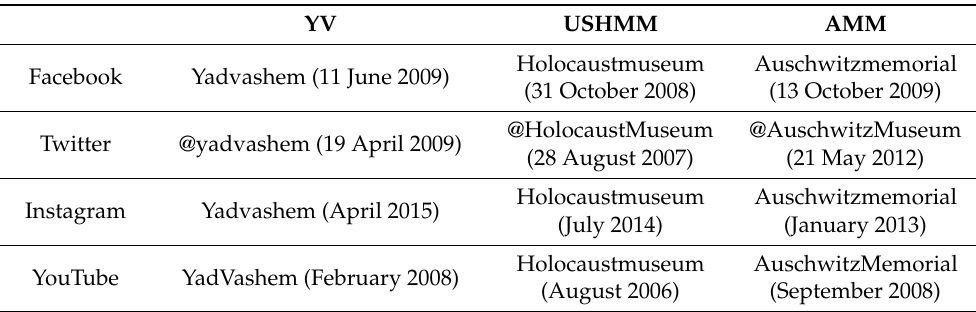
Table 1. List of social media profiles per museum (the date of profile creation/activation is shown in